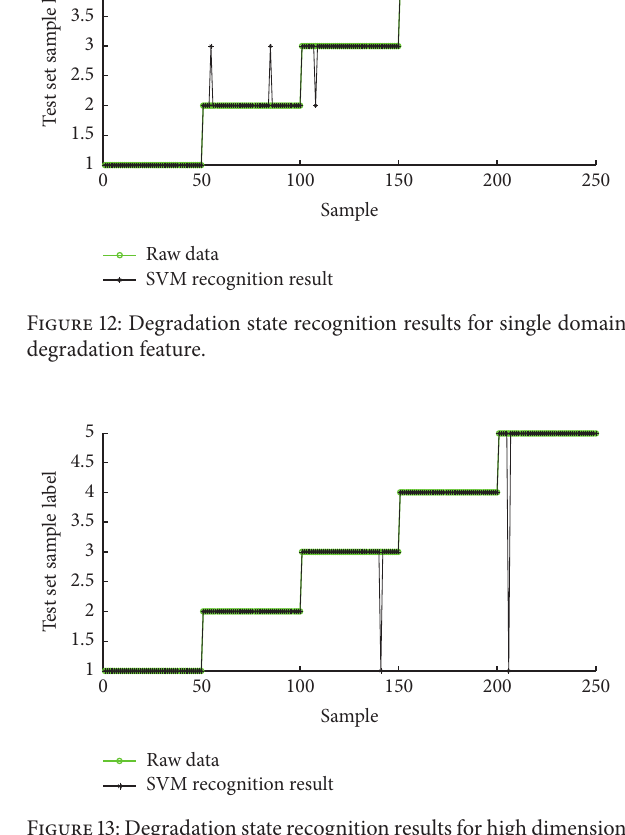
Figure 13: Degradation state recognition results for high dimension degradation